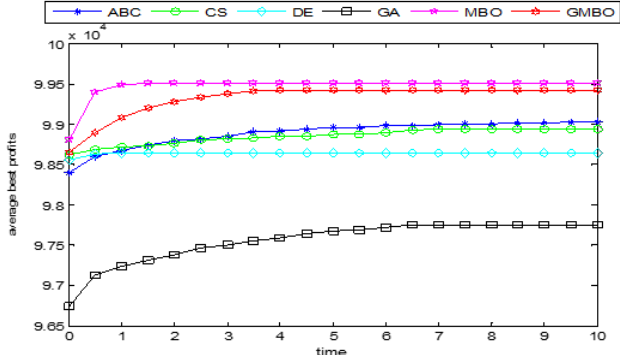
Figure 20. The convergence graph of six methods on KP5 in 10 seconds.